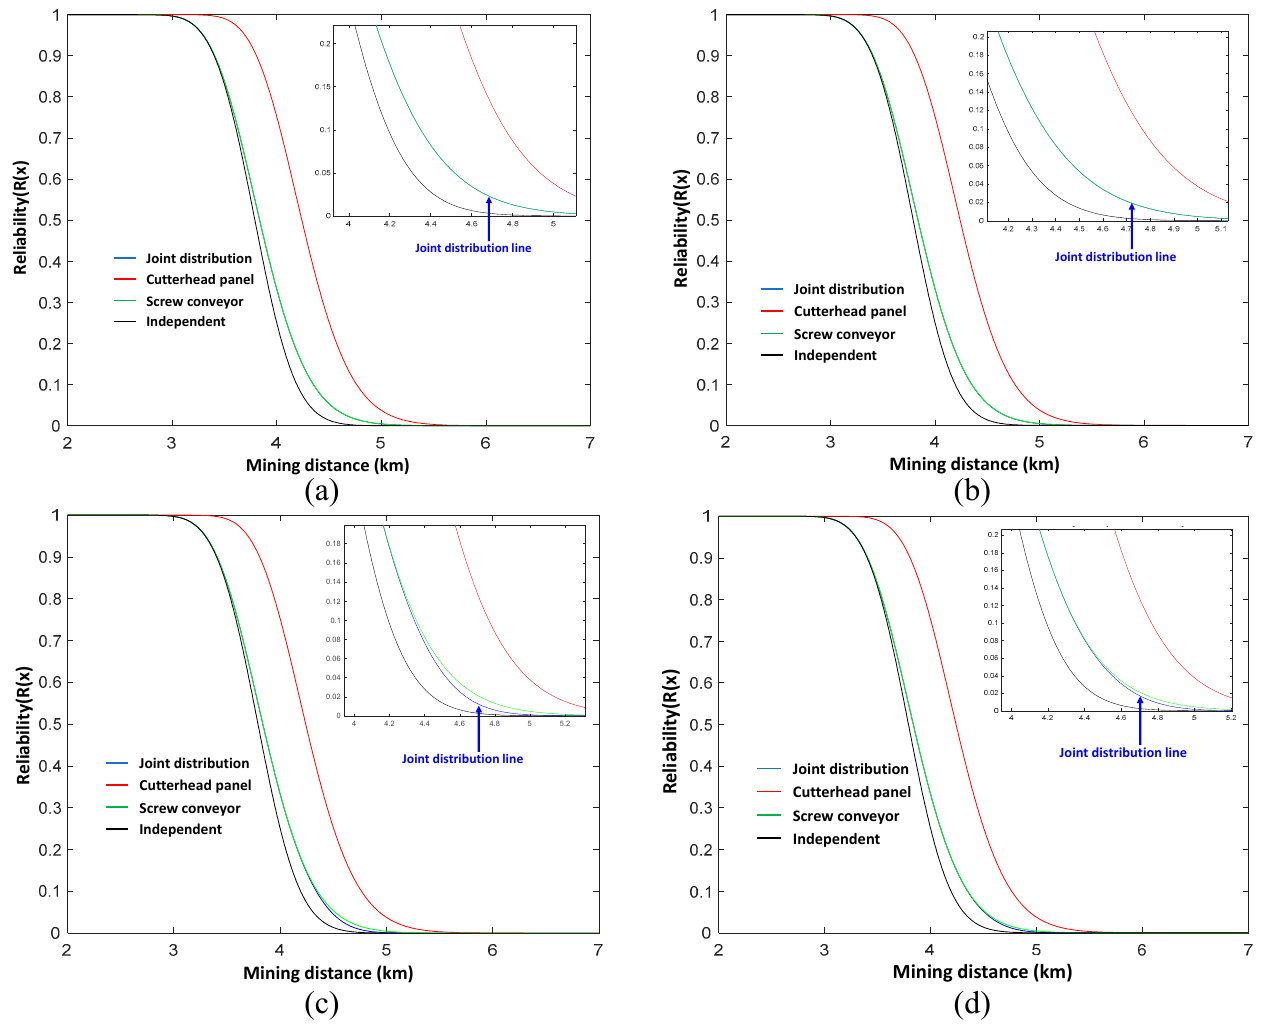
Figure 8. Joint distribution of reliability function by ( a ) Gumbel copula; ( b ) Gaussian copula; ( c ) Clayton copula; and ( d ) Frank copula. Table 13. Predicted mining distances (unit: km) under different copulas, independent conditions, and marginal distributions.